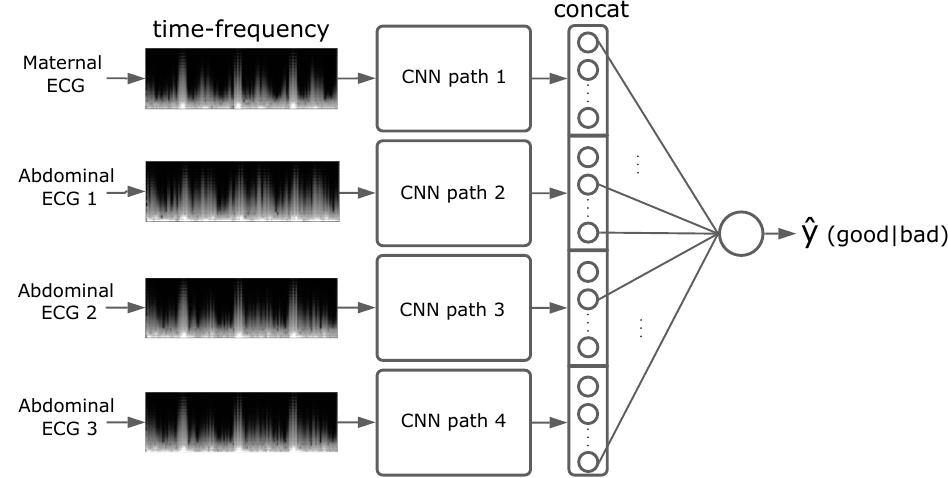
Figure 5. Neural network architecture for NI-FECG signal quality prediction.